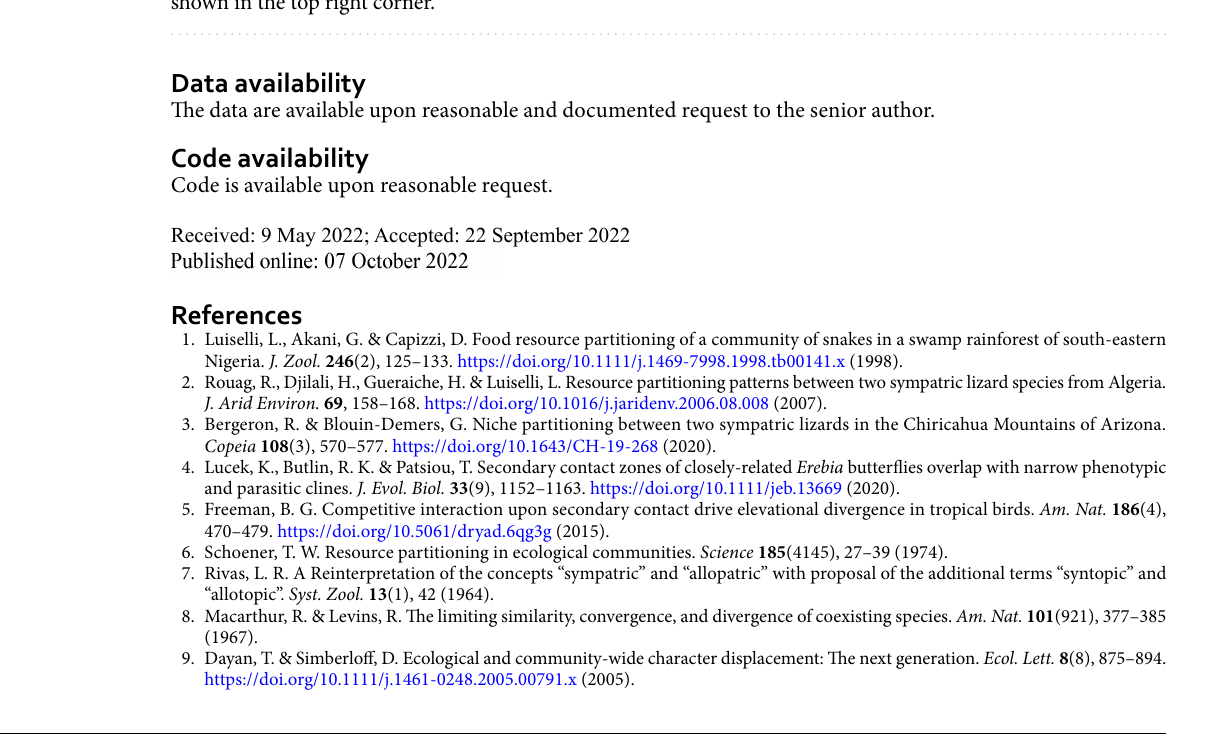
Figure 3. Visualisation of the marginal effects of productivity (left) and body size (right) on δ 13 C (top) and δ 15 N (bottom). Residuals of reduced models (identical to Model 2 in Table 1, but with the variable of interest excluded) are plotted against the variable of interest. Each dot represents a single individual. Color codes are shown in the top right